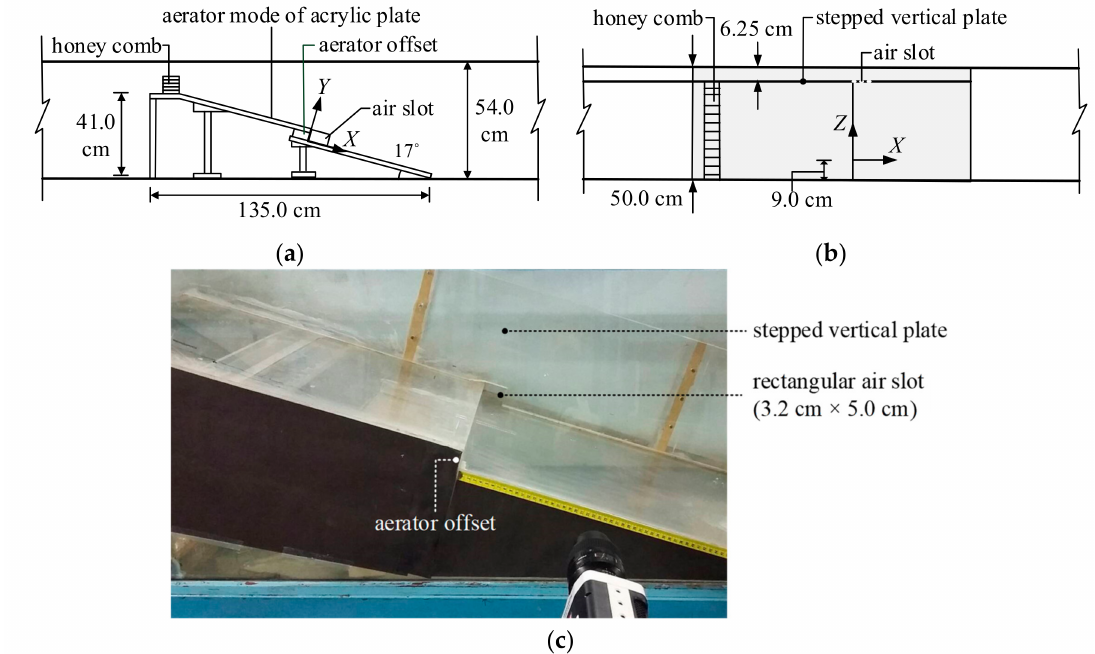
Figure 1. Schematic diagram of the aerator model mounted in the test section: ( a ) side view; ( b ) top view; ( c ) photo showing deployment of the offset, stepped vertical plate, and air